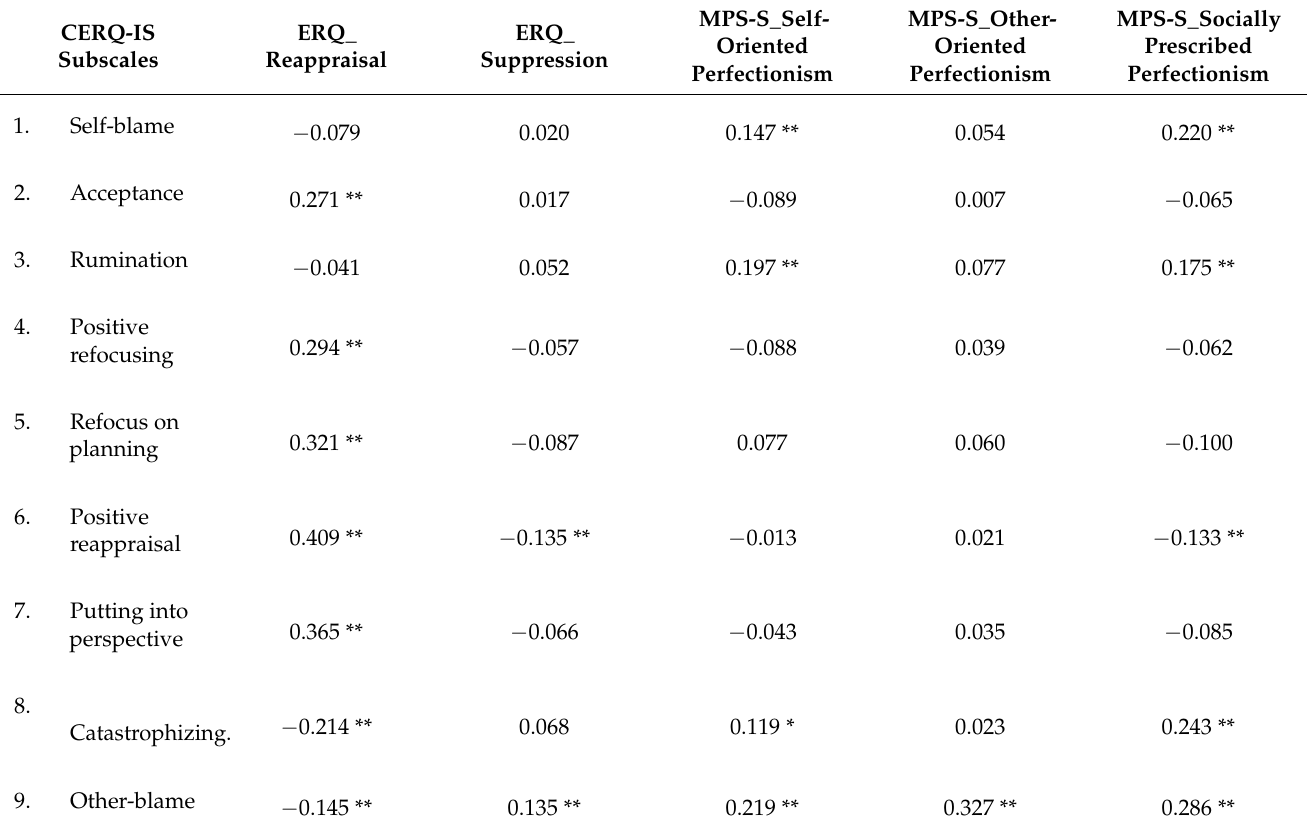
Table 3. Pearson’s correlations between CERQ-IS subscales and ERQ reappraisal and suppression scores, and MPS-S subscales scores. ** p < 0.01; * p < 0.05. Abbreviations: CERQ-IS, Italian short version of the cognitive emotion regulation questionnaire; ERQ, emotion regulation questionnaire; MPS-S, Multidimensional Perfectionism Scale—short